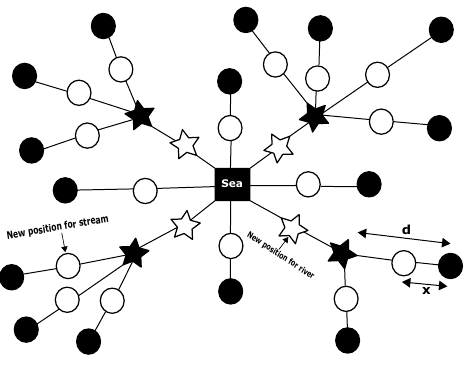
Figure 2. Transformation process.